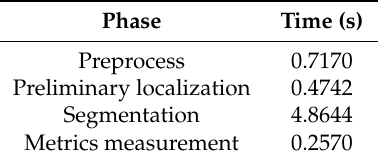
Figure 15. ROC curve of the classification results using the test set. Table 4. Execution times of each